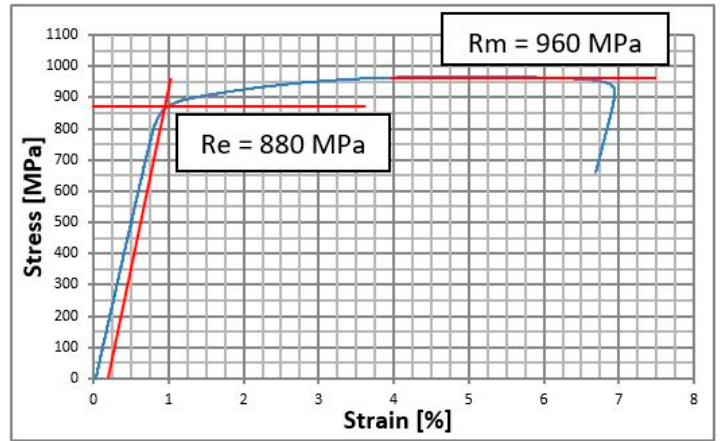
Figure 2. Stress strain curve for the Ti-6Al-4V Grade 5 titanium alloy.